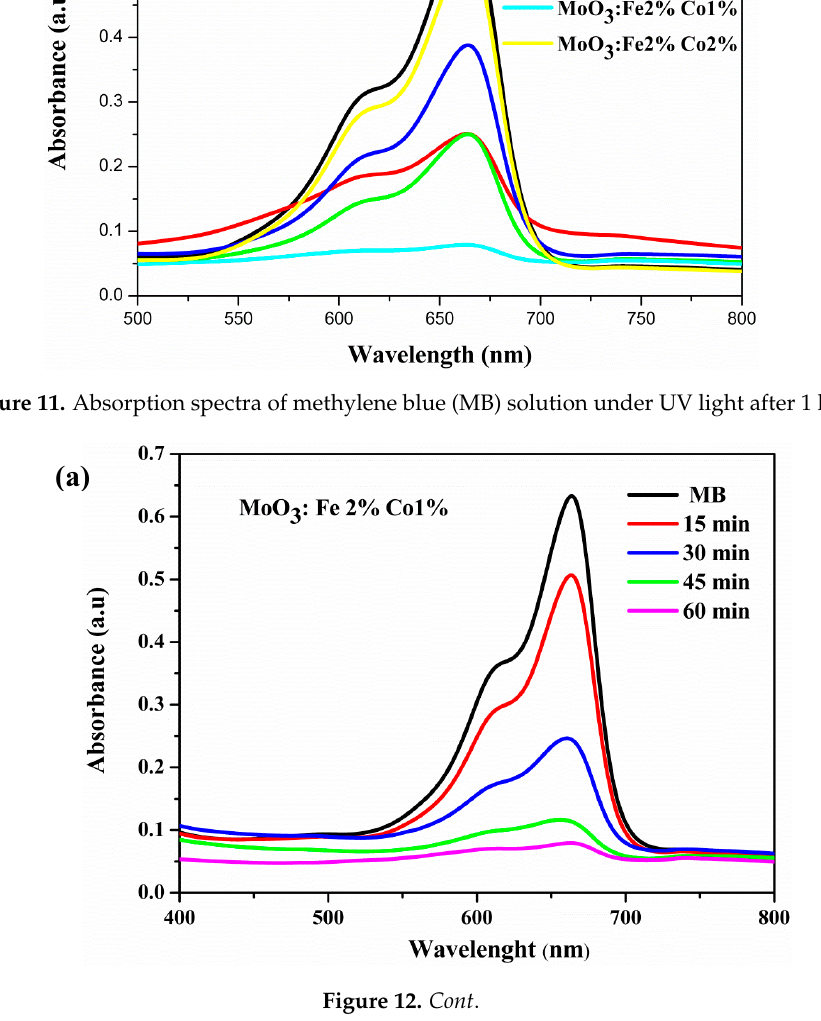
Figure 12. Time-dependent absorption spectra ( a ) of MB dye solution in the presence MoO 3 : Fe 2%- Co 1% ( b ) degradation efficiency and ( c ) degradation kinetics of MB dye. (c)